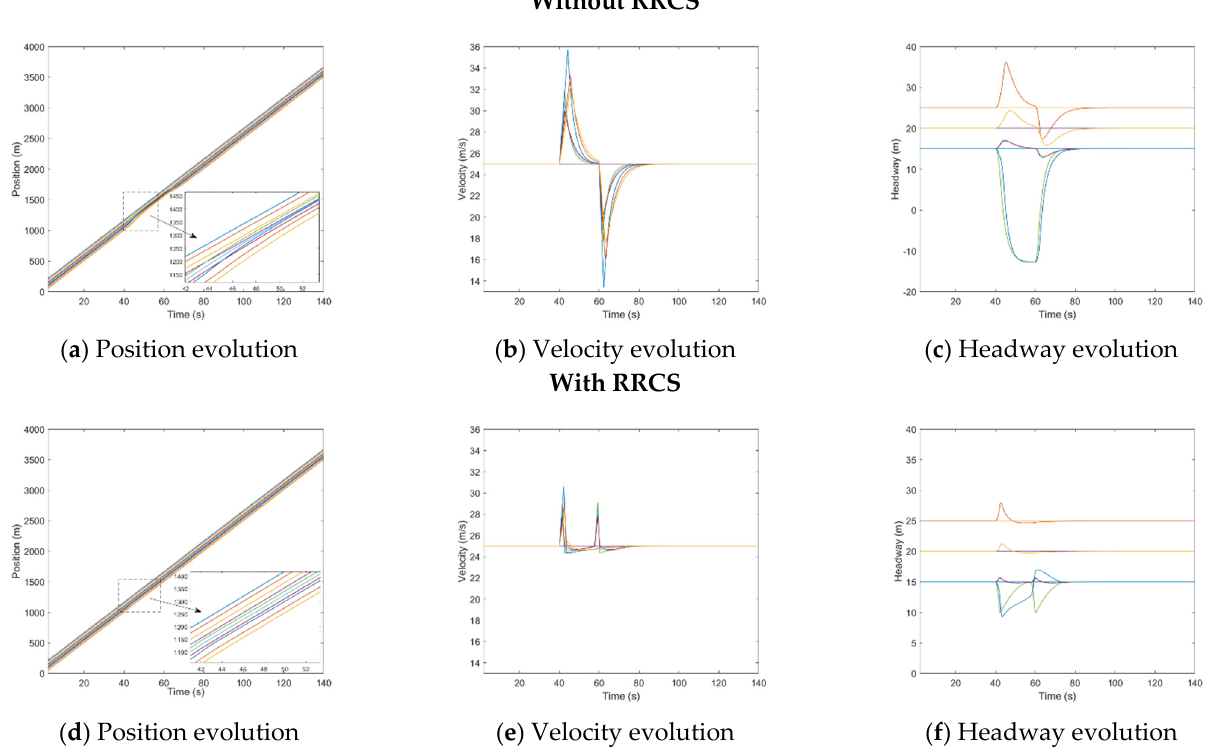
Figure A3. Mixed traffic flow evolution diagrams under collusion attacks (Type I) with/without RRCS in PATH’s CACC car − following models..